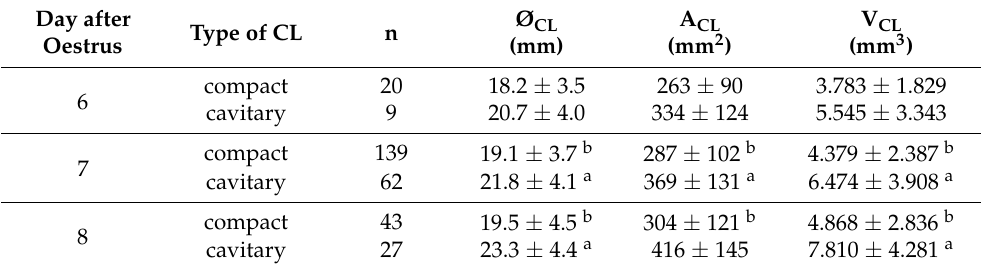
Table 2. Comparison of CL parameters on days 6, 7, and 8 after oestrus.